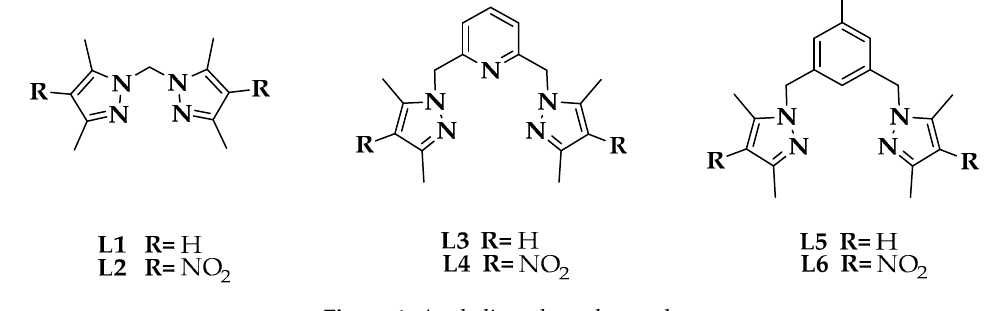
Figure 1. Azole ligands under study.